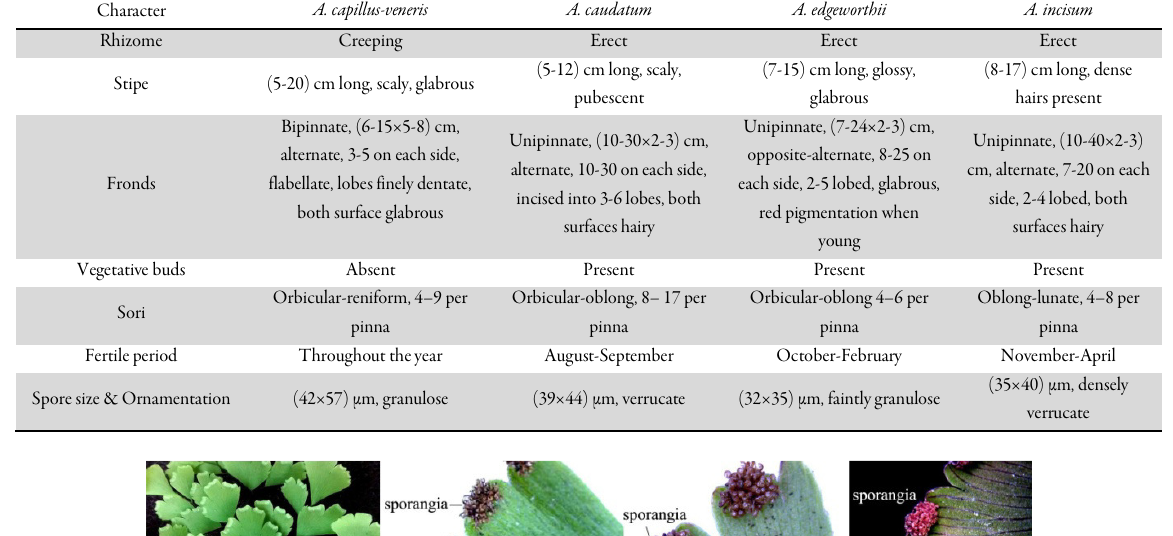
Table 3. Comparative morphology of the four species of Adiantum Character